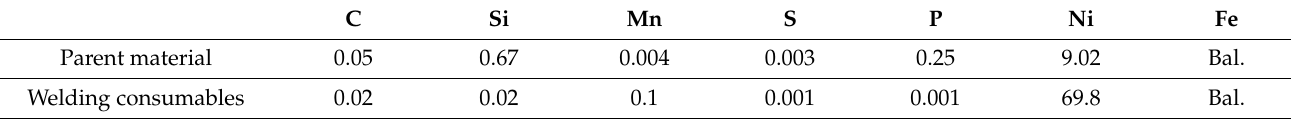
Table 2. Mechanical properties of 9% nickel steel [32].